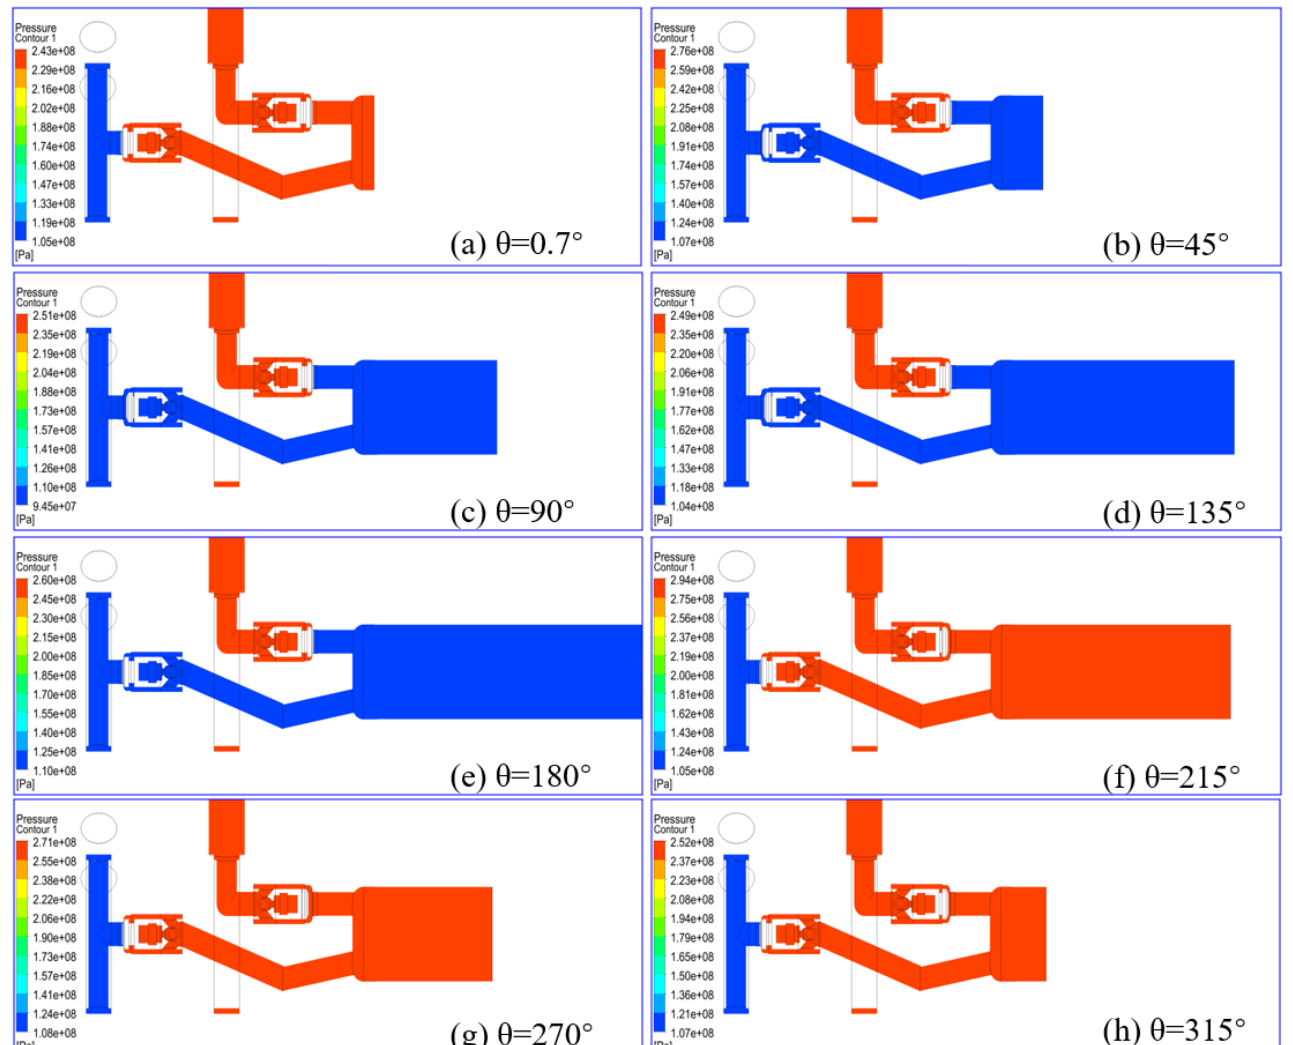
Figure 7. Pressure distribution and evolution during the working process of the hyper compres- sor.